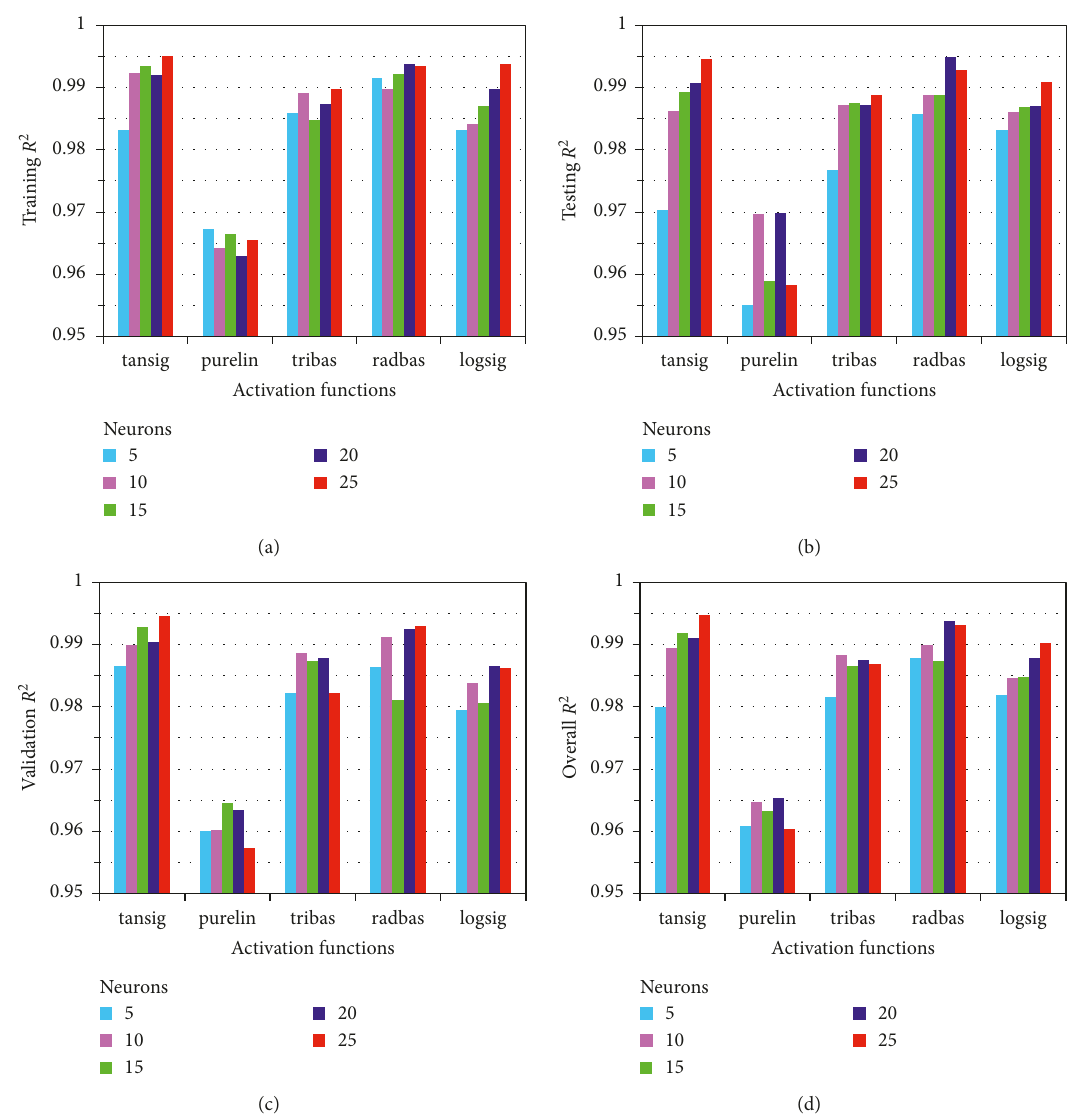
Figure 8: The coefficient of determination ( R 2 ) values for prediction of thermal diffusivity.